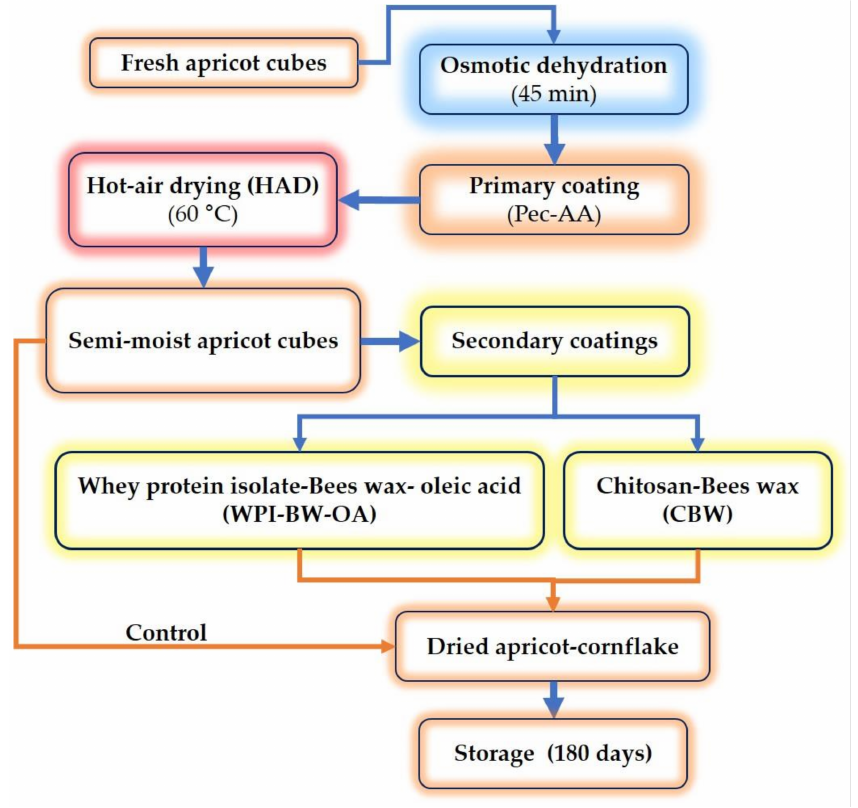
Figure 1. Experimental flowchart to produce semi-moist coated apricot